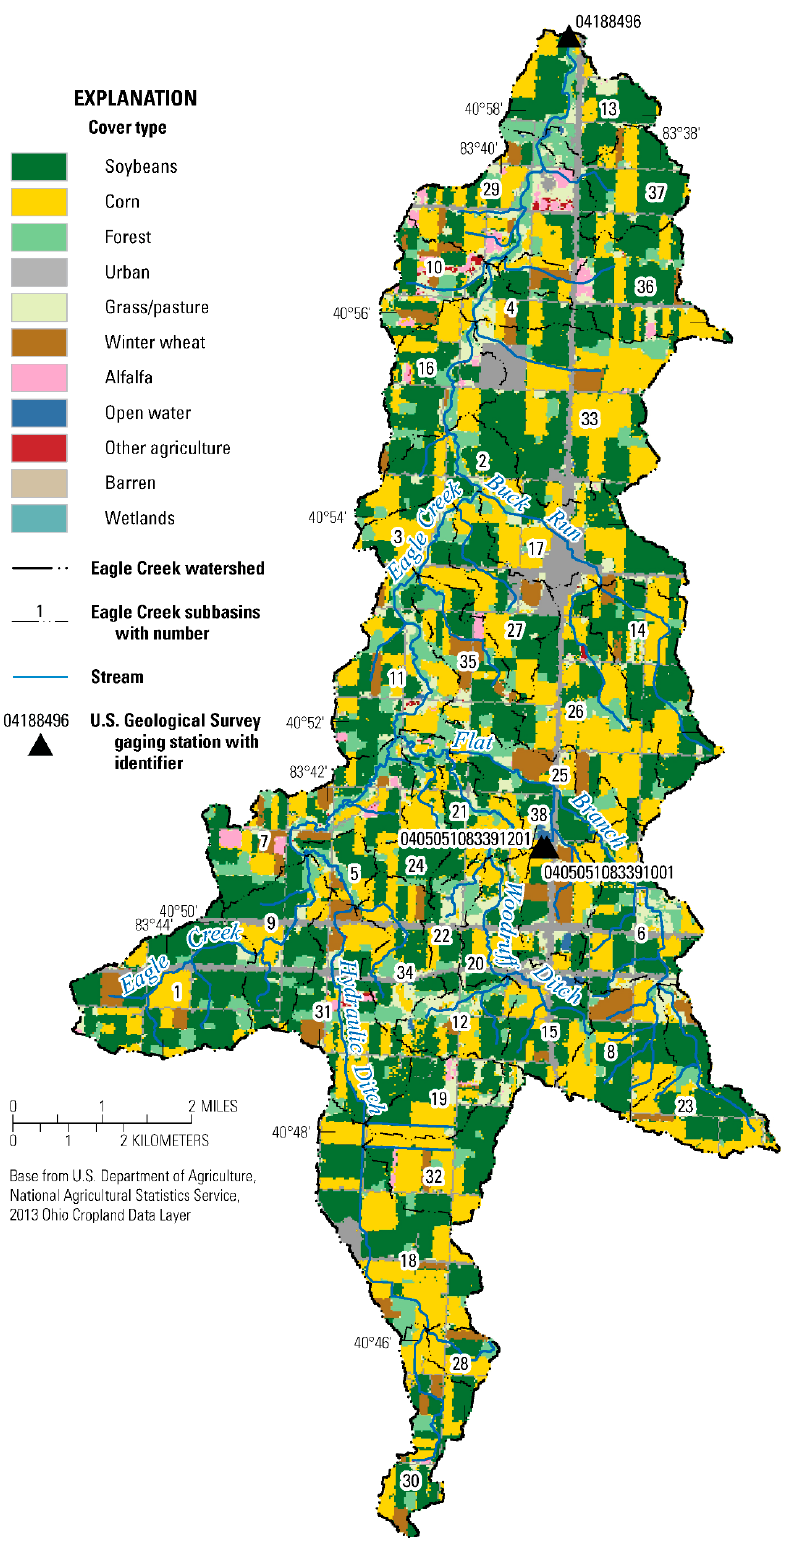
Figure 2. Land use and delineated subbasins in the Eagle Creek watershed, Ohio.